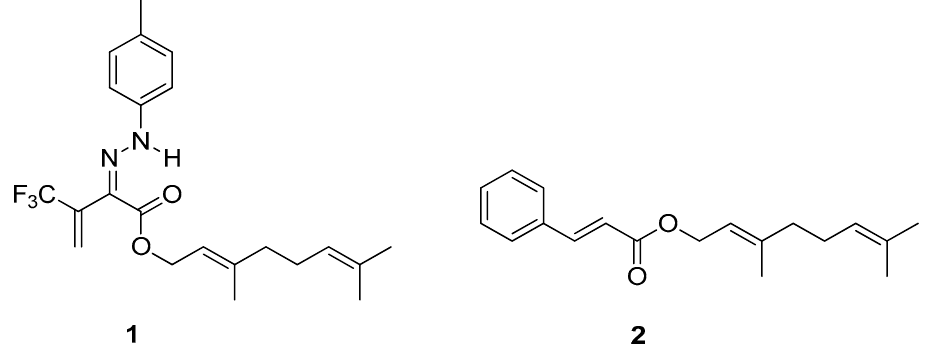
Figure 3. Ester derivatives of naturally occurring geraniol.